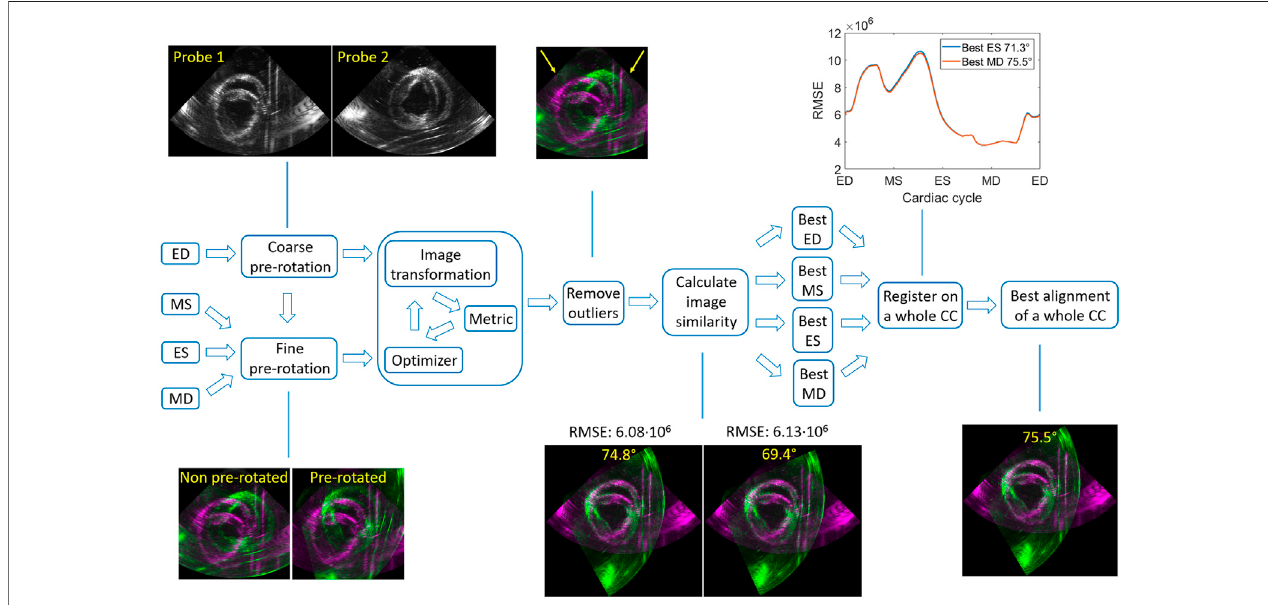
FIGURE 2 | Overview of the fully automatic image